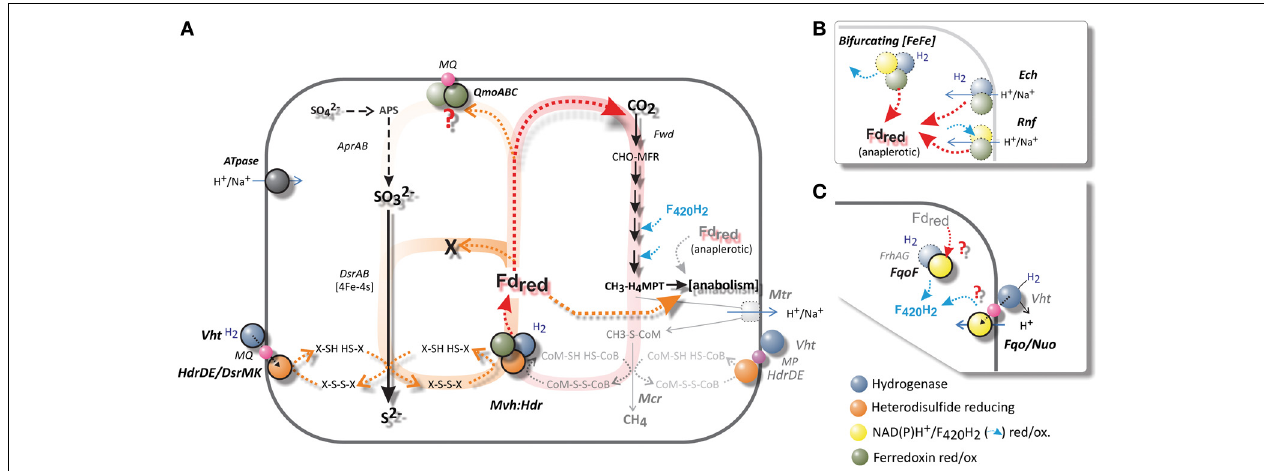
borders), which are absent in A. fulgidus . Most methanogens and SRP maintain several of these complexes. The Wolfe cycle requires an anaplerotic ferredoxin (Fd)-reducing hydrogenase (Ech/Eha), in order to fixate carbon in anabolic processes. (C) Putative mechanisms for generation of F 420 H 2 . Complexes absent in A. fulgidus outlined in (B) : the electron bifurcating [Fe-Fe] hydrogenase (Huang et al., 2012), the Rnf complex (Biegel et al., 2011; Tremblay et al., 2013), the energy converting hydrogenase (Ech), (C) : the F 420 -reducing hydrogenase (Frh) (Thauer et al.,